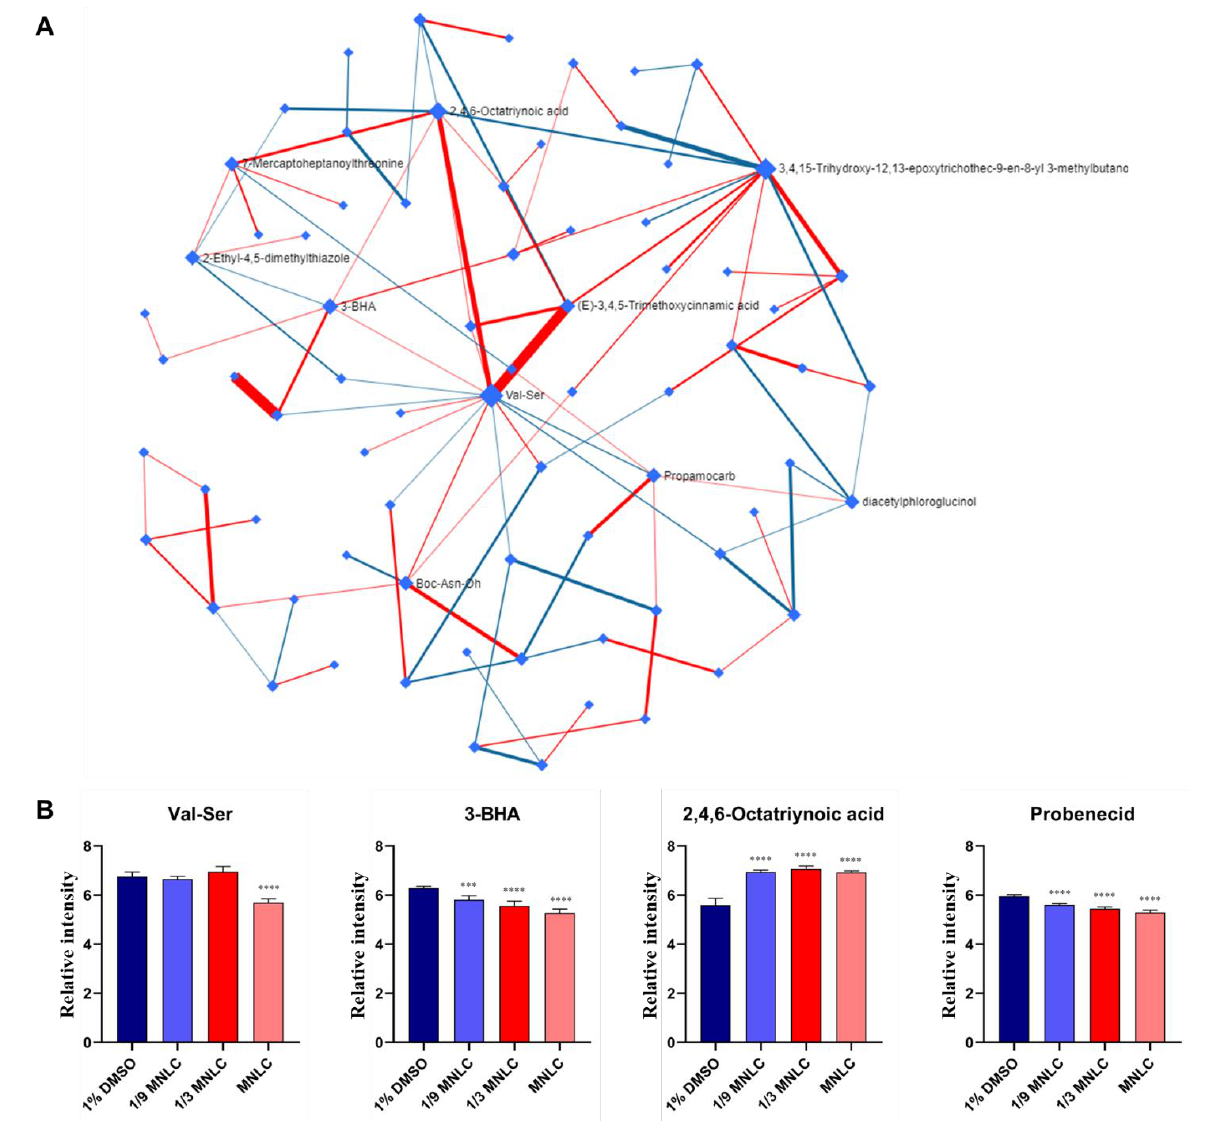
Figure 6. ( A ) Debiased Sparse Partial Correlation (DSPC) network of significantly differential metabolites. In the DSPC network, the nodes are input metabolites, while the edges represent the association measures. Metabolites with stronger associations cluster together and the edges between them are wider. The red lines show a positive correlation, while blue lines show a negative correlation with metabolites. ( B ) The relative concentration level of important metabolites in the DSPC network. The data were log 10 transformed and asterisks denote statistical significance according to a multiple group comparison of ANOVA (only significative results of exposed groups vs. solvent control are illustrated); *** p -value < 0.001, **** p -value < 0.0001.